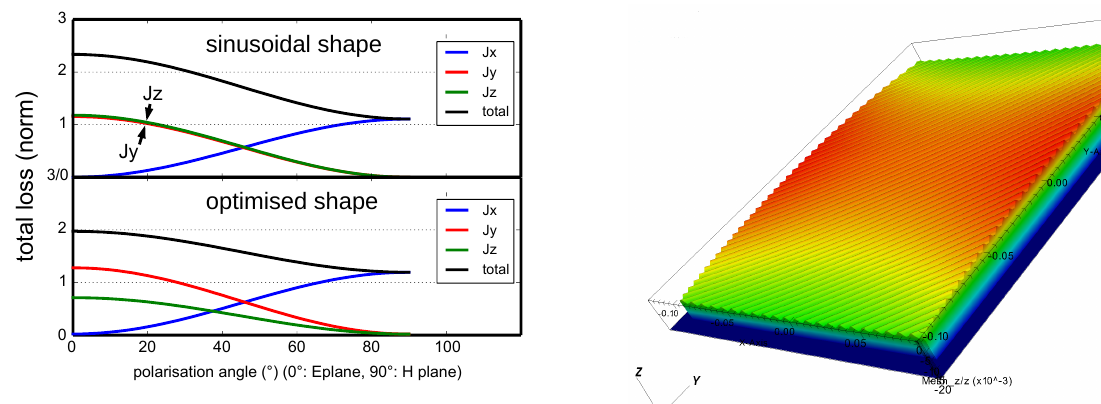
Figure 6. Shape of the holographic grating tile R7 for ASDEX Upgrade used in the